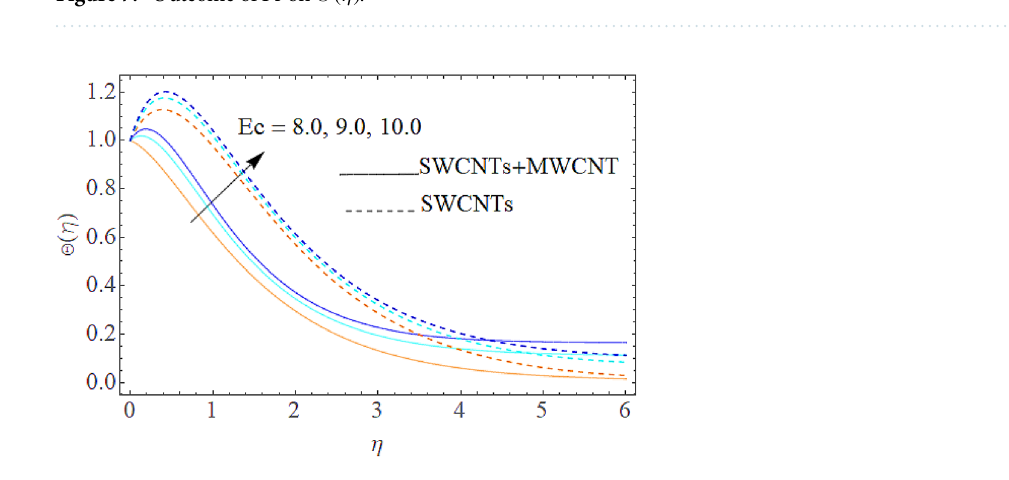
Figure 7. Outcome of Pr on �(η) .